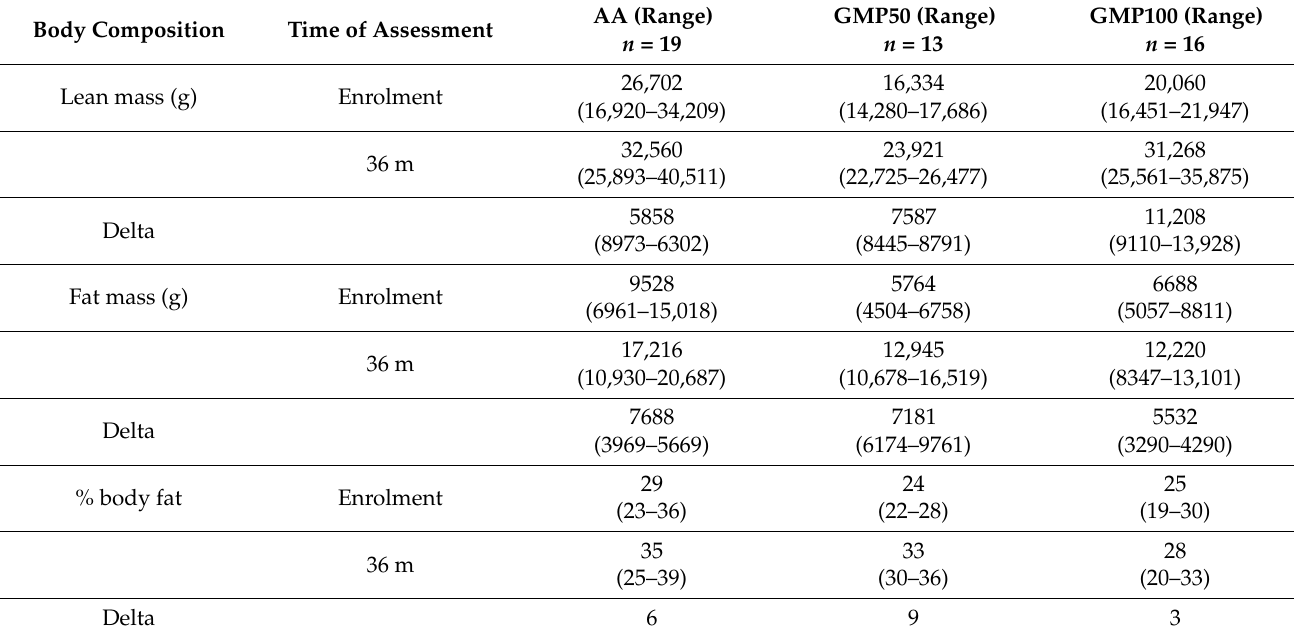
Table 2. Median (range) lean mass, fat mass and % body fat in the AA, CGMP50 and CGMP 100 groups at enrolment and 36 months.